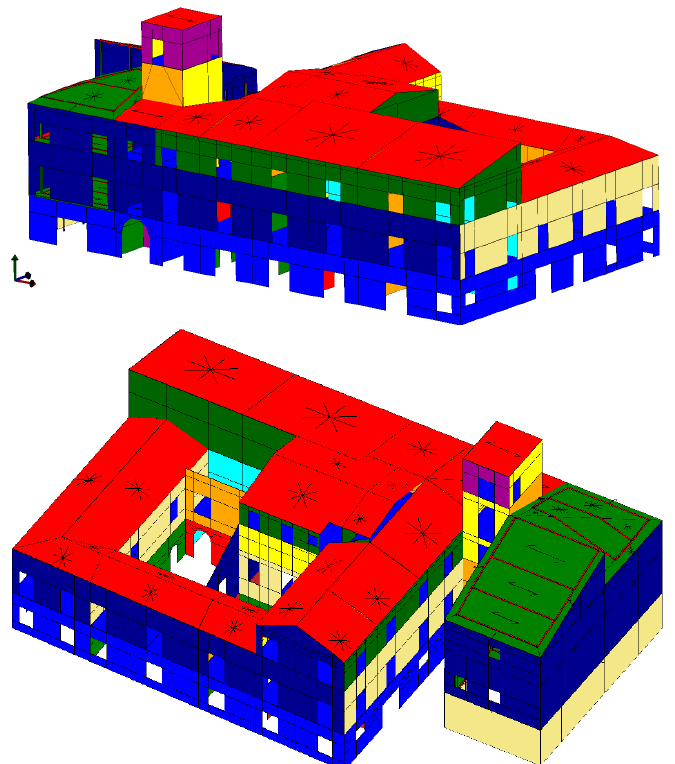
Figure 11. Computational model: axonometric views.